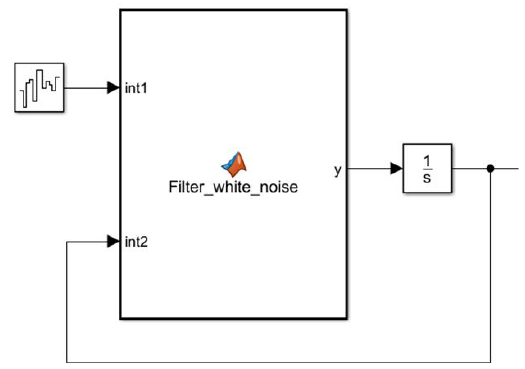
Figure 9. Time domain model of random pavement generation.